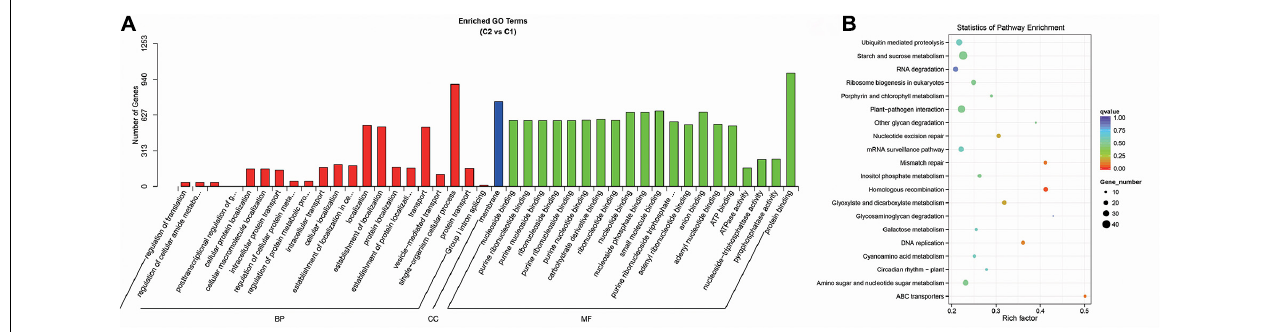
FIGURE 15 | Enrichment analysis of candidate target genes for differentially expressed miRNA between the C2 and C1 groups. (A) Histogram of GO enrichment for candidate target genes from C2 vs. C1. Three basic classifications of Go term (from left to right, BP, biological processes; CC, cellular components; MF, molecular functions). (B) KEGG enrichment scatter plot of candidate target genes from C2 vs. C1. X -axis, the Rich factor; Y -axis, the name of the pathway. The size of the dots indicates the number of candidate target genes in this pathway, and the colors of the dots correspond to different Q value ranges. C1: BcL.1-25 , C2: BcL.1-4 , C3: BcL.2-25 , C4: BcL.2-4